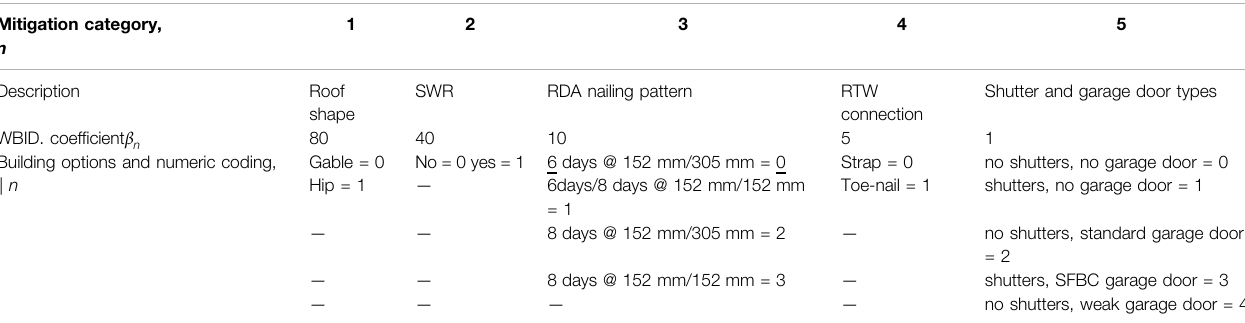
TABLE 1 | Descriptions and numerical coding for one-story, single-family, residential building WBID calculation (adapted from Orooji and Friedland 2017). Mitigation category, n Description Roof